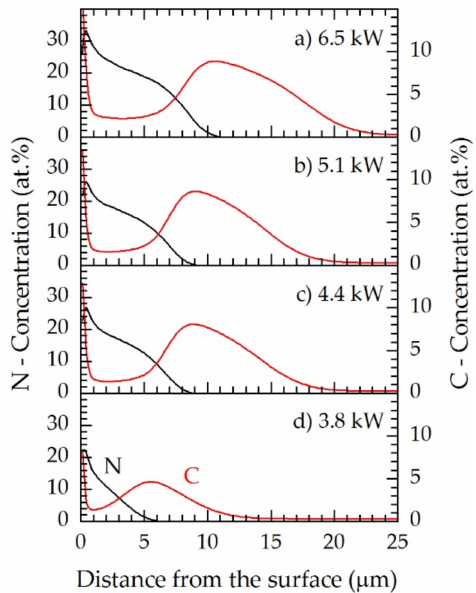
Figure 6. GDOES (glow discharge optical emission spectroscopy) concentration–depth profiles for nitrogen (left axis, black) and carbon (right axis, red) for the plasma power values at the active screen (AS) of ( a ) 6.5 kW, ( b ) 5.1 kW, ( c ) 4.4 kW, ( d ) 3.8 kW for N 2 :H 2 = 1:1; T = 733 K; t = 5